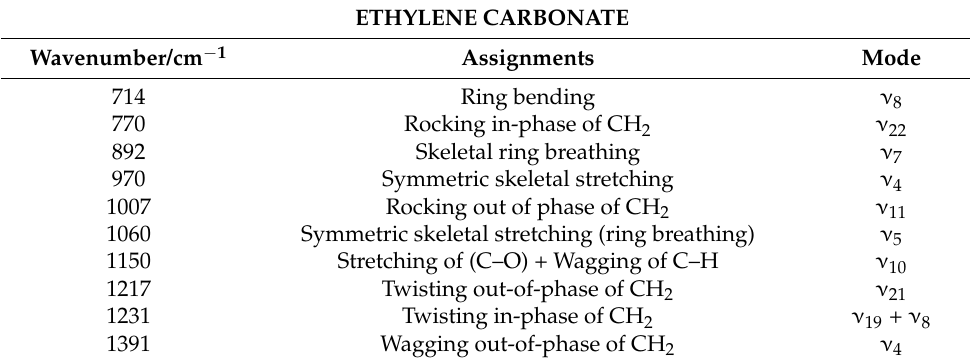
Table 1. Assignments of the main IR modes of the spectra collected on the polymeric gel denominated: PMMA-Li-PC and